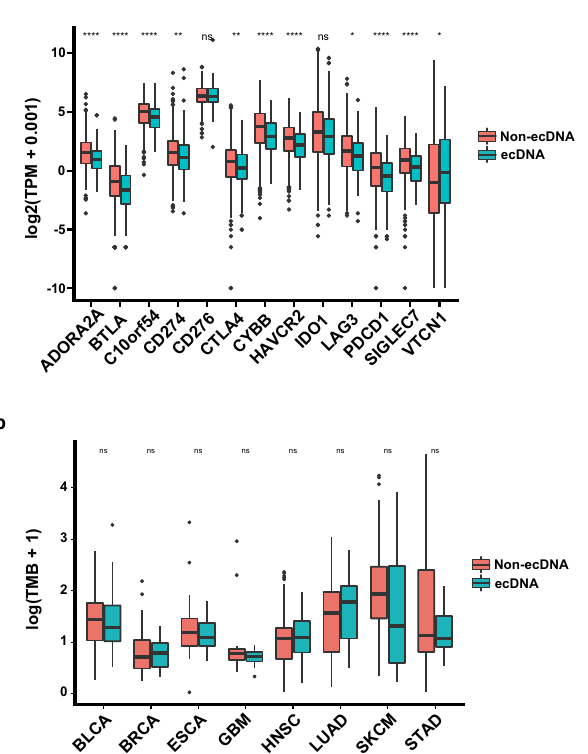
Figure 4. ecDNA and expression of inhibitory immune checkpoint genes and TMB. ( a ) Expression of inhibitory immune checkpoint genes in tumors with ecDNA and without ecDNA. Wilcoxon test P values are shown. ( b ) Tumor mutation burden (TMB) difference in different types of tumors with and without ecDNA. Wilcoxon test P values are shown. ns: P > 0.05, *: P ≤ 0.05, **: P ≤ 0.01, ***: P ≤ 0.001, ****: P ≤ 0.0001. TCGA cancer type acronyms: STAD (stomach adenocarcinoma), SKCM (skin cutaneous melanoma), HNSC (head and neck squamous cell carcinoma), LUAD (lung adenocarcinoma), BLCA (bladder urothelial carcinoma), BRCA (breast invasive carcinoma), ESCA (esophageal carcinoma), GBM (glioblastoma